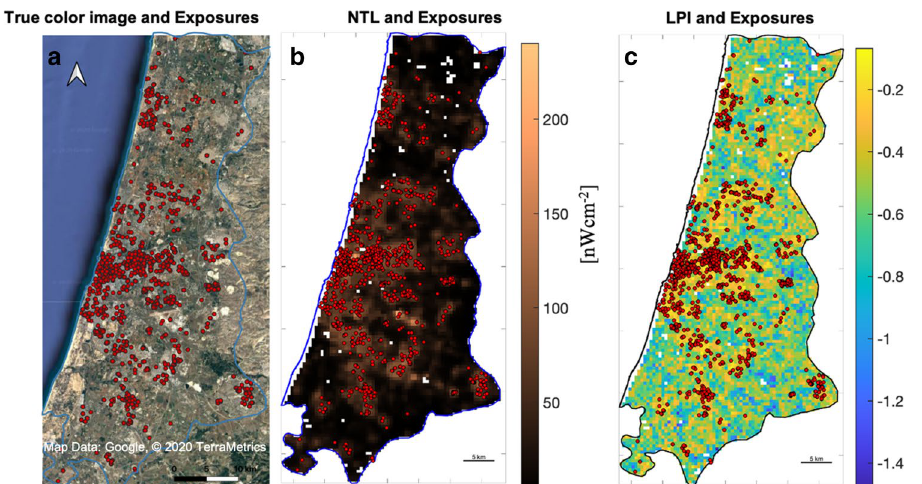
Figure 3. Spatial distribution of RLSC in Gush Dan District. RLSC in Gush Dan (red points), overlaid on (a) a Google maps satellite image. Blue line delineates the borders of Gush Dan district; (b) NTL map; (c) LPI map. Note that RLSCs preferentially occur in regions with high LPI values, which correspond to regions with high NTL values. Panel 3a created using QGIS 31 , panels (b,c) created using MATLAB 43 (for more information see “Method” section, subsection “Satellite